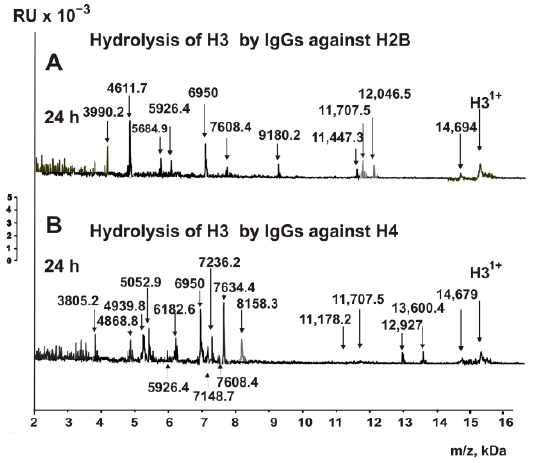
Figure 2. MALDI spectra corresponding to the H3 histone (0.8 mg/mL) over the time of hydrolysis in the presence of IgGs (0.04 mg/mL) against H2B ( A ) and H4 ( B ). All of the used antibody prepa- rations and the molecular masses ( m / z , Da) of the products are indicated on the panels; RU — relative